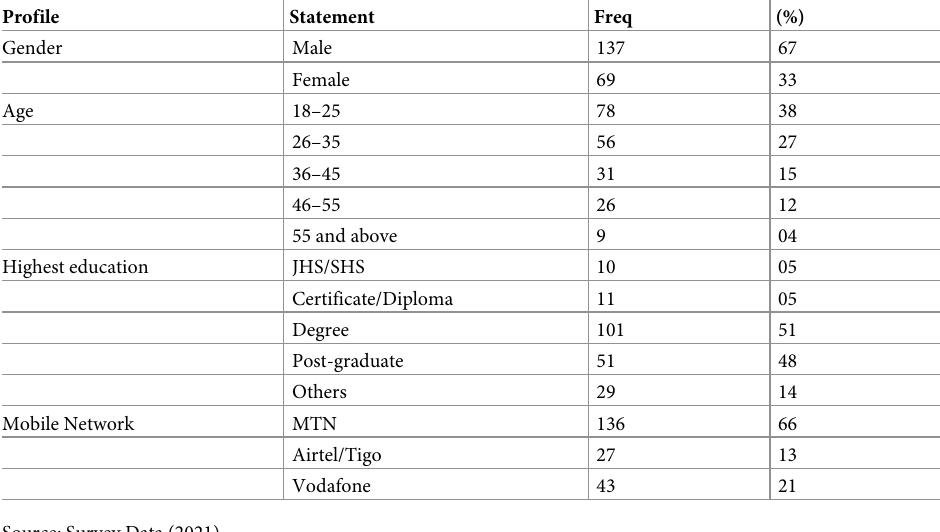
Table 2. Profile of respondents [n =